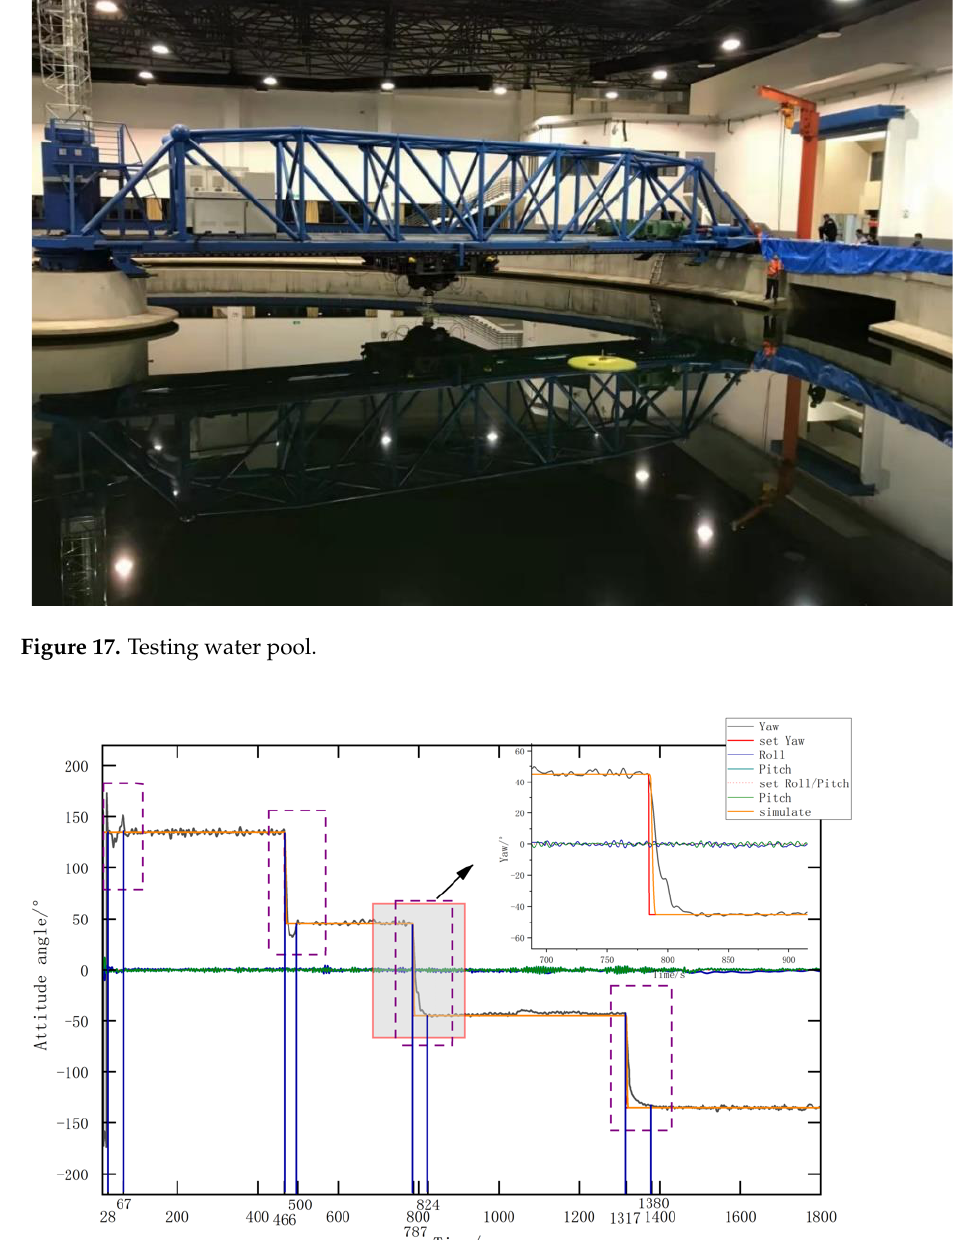
Figure 19. Attitude control result in hovering mode.